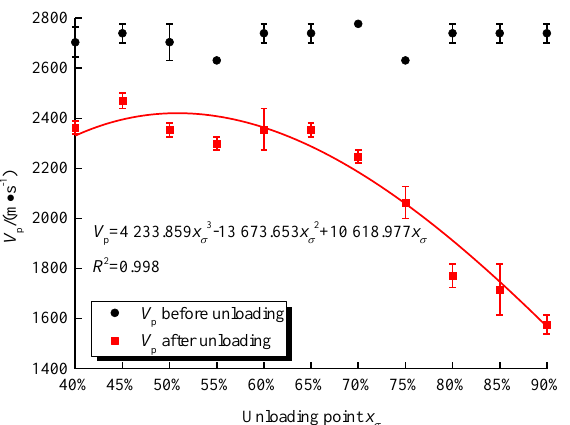
Figure 10. Wave velocity variation diagram of sandstone before and after peak unloading.